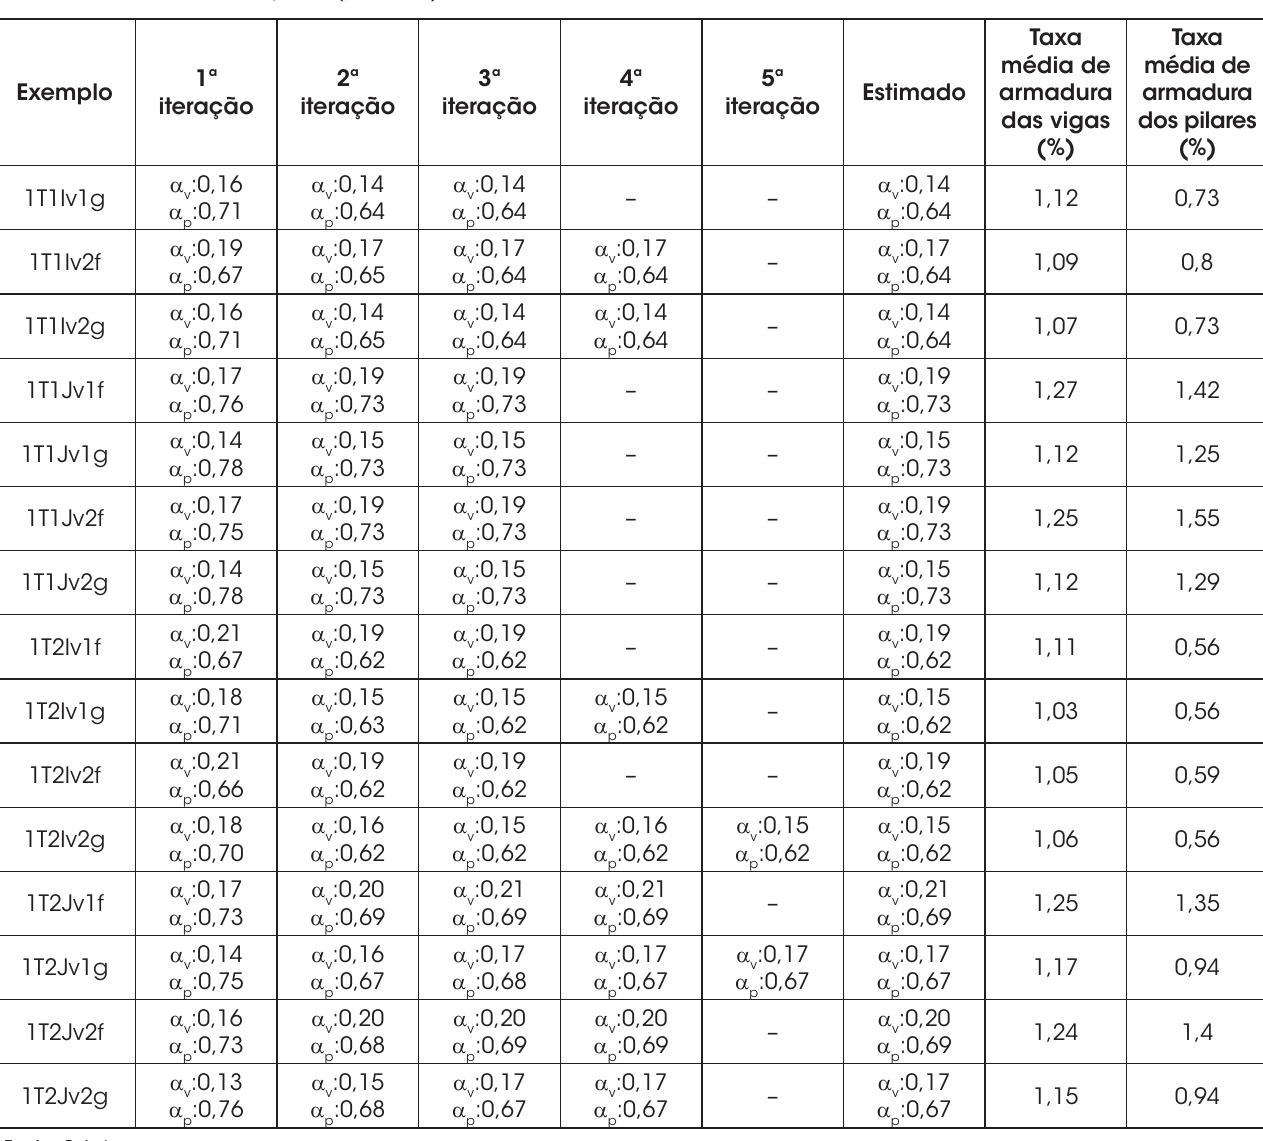
Resultados das simulações (parte 3)